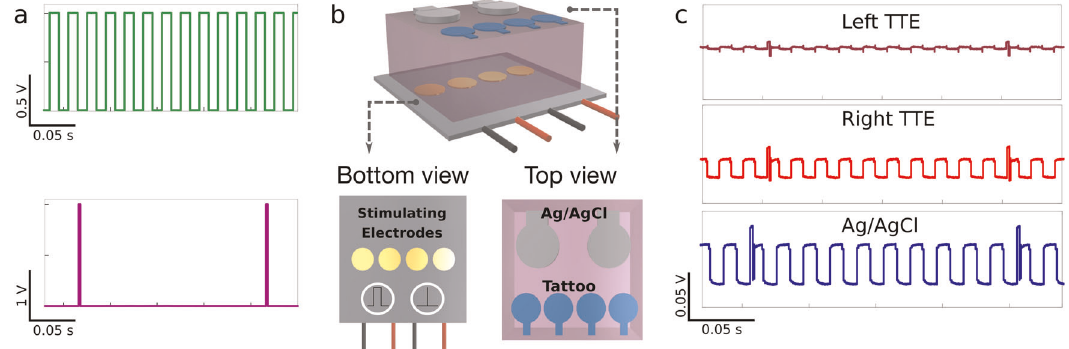
Fig. 5 High-density EEG recording through the phantom experimental set-up. a Input signals from the bottom stimulating electrodes: the 50 Hz square wave is sent at the left couple of electrodes (top) and the 5 Hz square wave sent at the right couple of electrodes (bottom). b Rendering of the phantom with recording electrodes positioned on top. Bottom view of the input electrodes dedicated to initiate bipolar inputs. Top view of the phantom with Ag/AgCl electrodes and TTEs. c The recorded output signals from the phantom. From the top: the signal from the left couple of TTEs; the signal from the right pair of TTEs; the signal from the Ag/AgCl